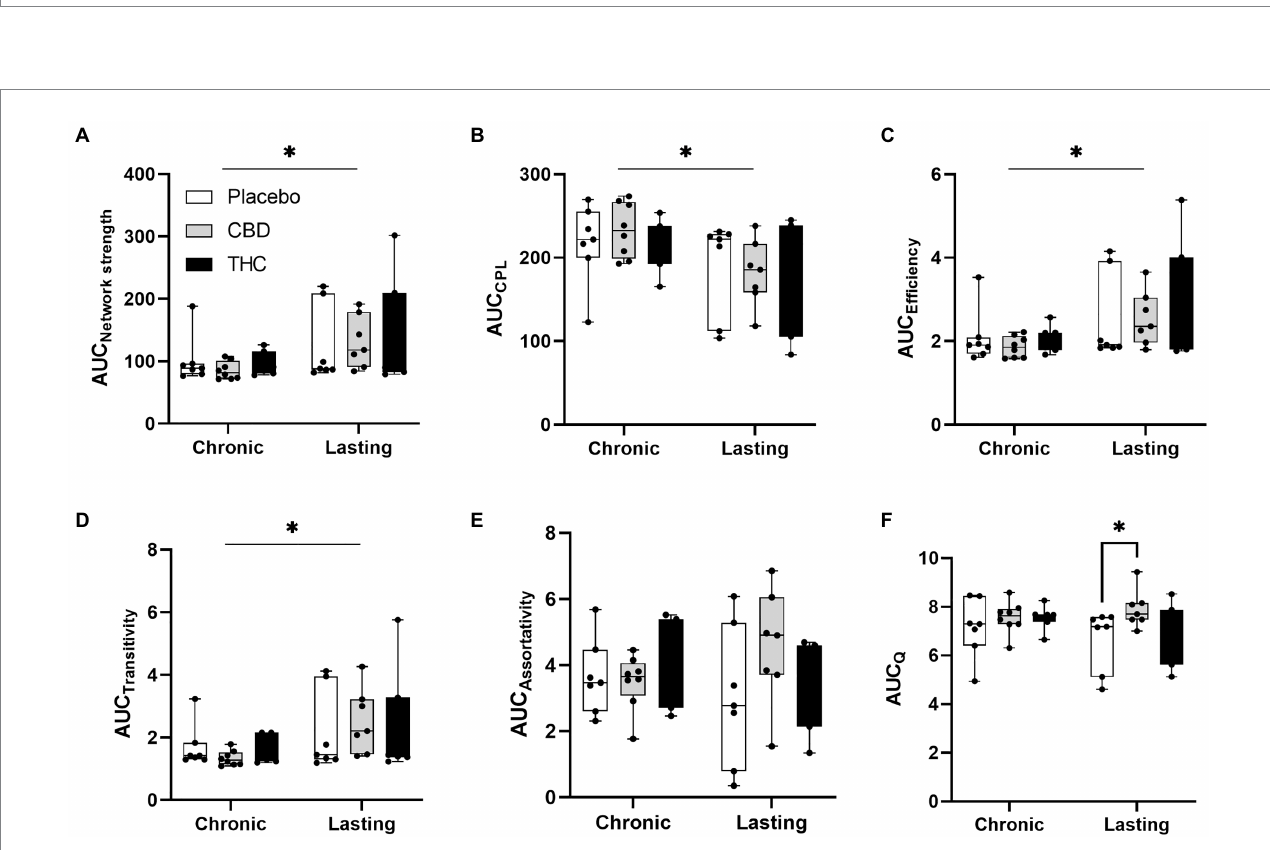
FIGURE 8 Network modularity. CBD administration results in increased modularity following a 2-week washout period. The network measures shown include (A) node strength, (B) characteristic path length, (C) efficiency, (D) transitivity, (E) assortativity and (F) modularity. Strength, CPL, efficiency, transitivity differed between chronic and lasting imaging sessions (two-way ANOVA main effect of imaging epoch). Data are presented as area under the curve (AUC) values for network measures in Figure 7 calculated for multiple edge density thresholds (2–40%). Individual data points are overlaid on box and whisker plots (mean-max). Statistical analyses done using two factor ANOVA (main effect imaging epoch and drug treatment with Dunnett’s multiple comparison post-hoc test * p < 0.05). Abbreviations: CPL, characteristic path length; Q, modularity